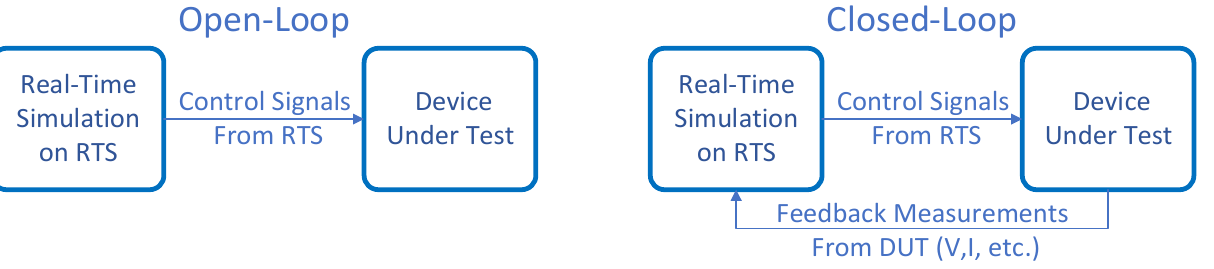
Figure 2. Open-loop vs. closed-loop testing diagrams for power system PHIL applications.